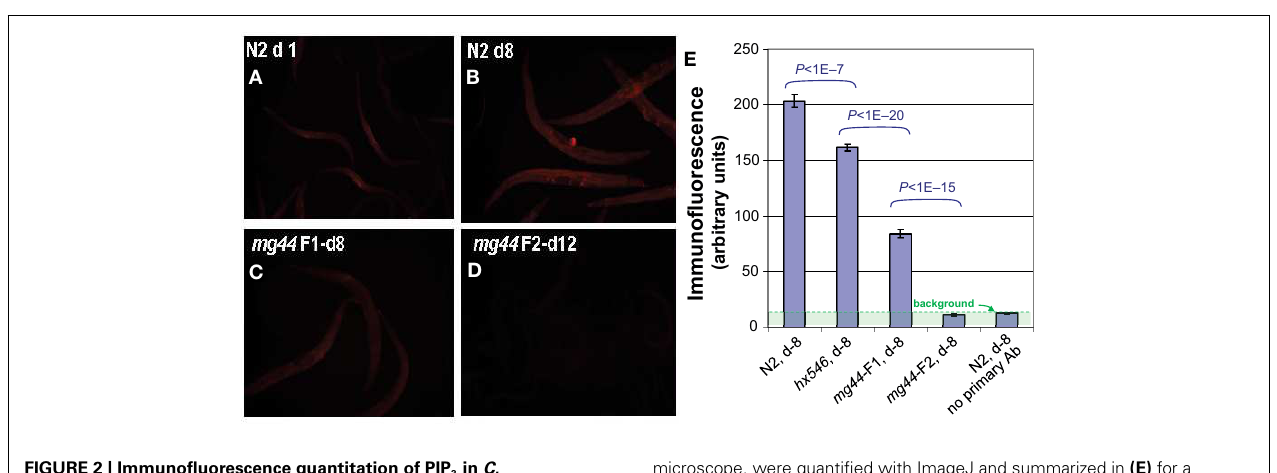
FIGURE 2 | Immunofluorescence quantitation of PIP 3 in C. elegans . Worms were permeabilized as for Figure 1 and incubated with mouse antibody to PIP 3 (Echelon), followed by a 1:200 dilution of secondary antibody, ALEXA594-labeled goat anti-mouse IgG (Invitrogen). Images (A–D) , acquired on an Olympus BX51